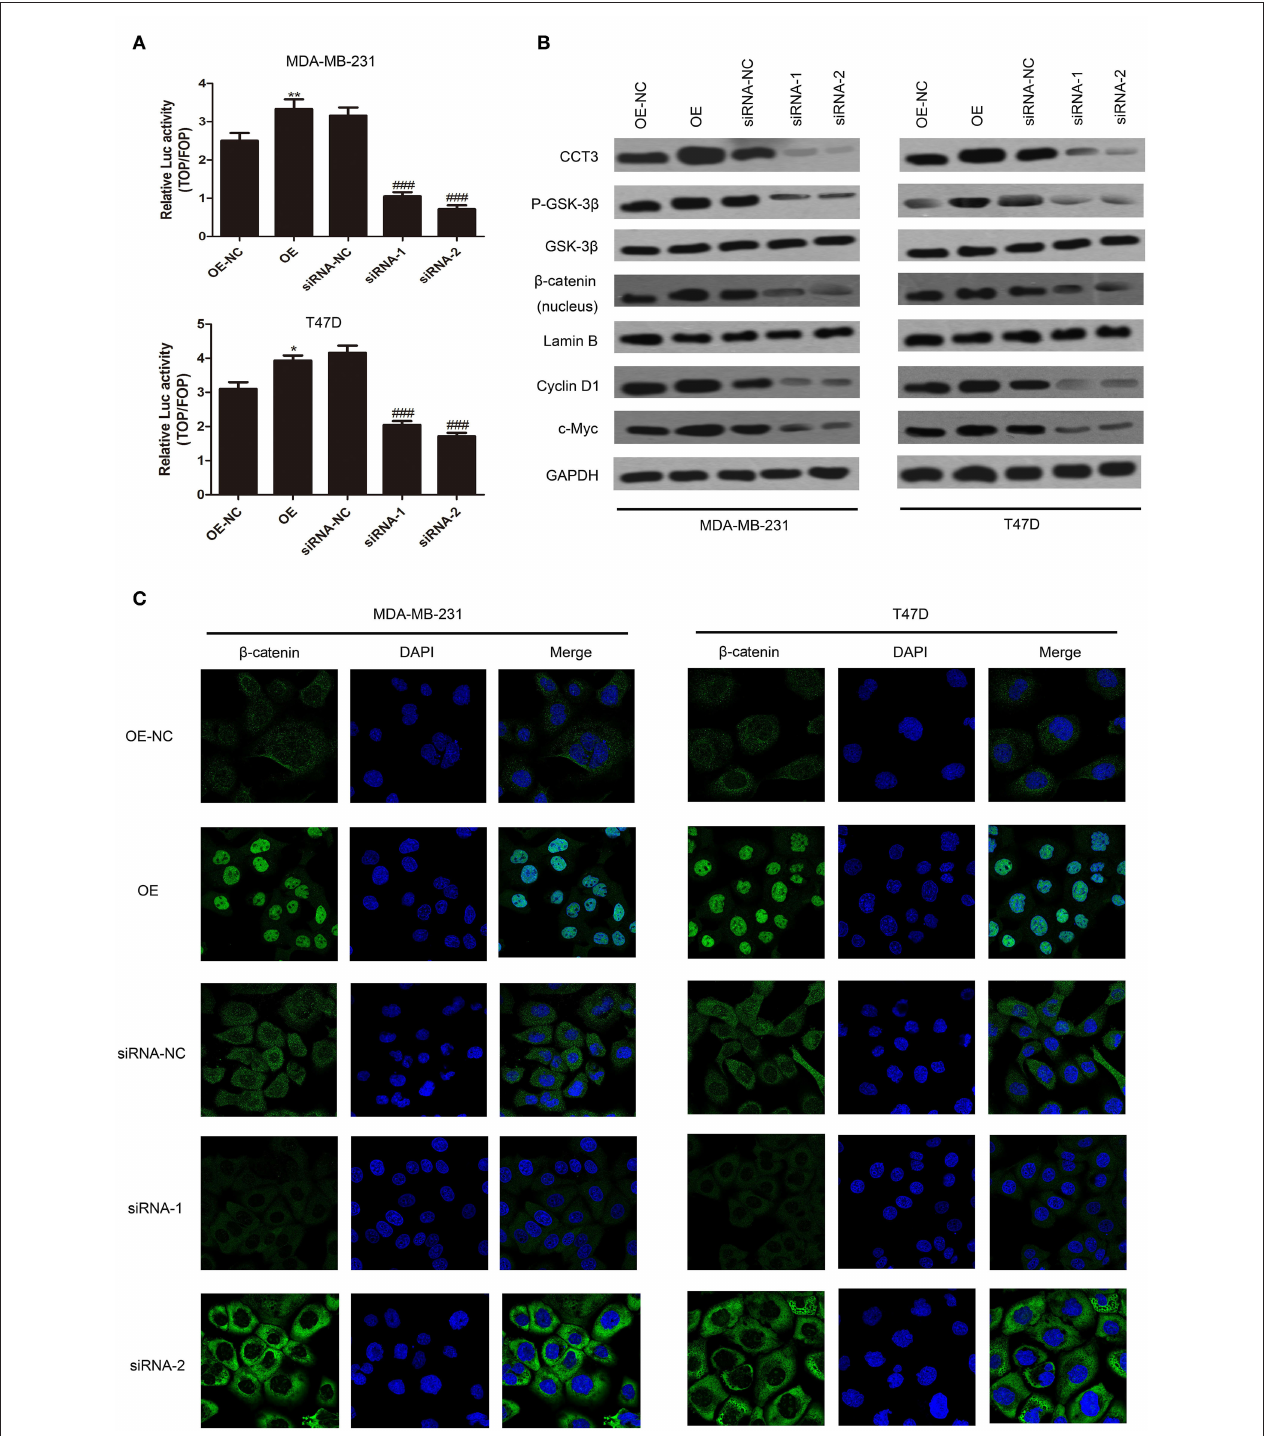
FIGURE 3 | CCT-3 promotes breast cancer cell proliferation through Wnt/ β -catenin signaling pathway activation. (A) TOP/FOP flash indicated that the Wnt/ β -catenin signaling pathway activation was regulated by CCT-3. Values are mean ± SD of three independent experiments. * p < 0.05, ** p < 0.01 (OE vs. OE-NC), ### p < 0.001 (siRNA vs. siRNA-NC), t -test. (B) Protein levels of CCT-3, p-GSK-3 β , GSK-3 β , β -catenin (nucleus), cyclin D1, and c-Myc in CCT-3-overexpressed and CCT-3-silenced cells. Lamin B and GAPDH were used as loading controls. (C) The translocation of β -catenin from the cytoplasm to the nucleus was detected by immunofluorescence staining following CCT-3 overexpression and inhibition in breast cancer cells.